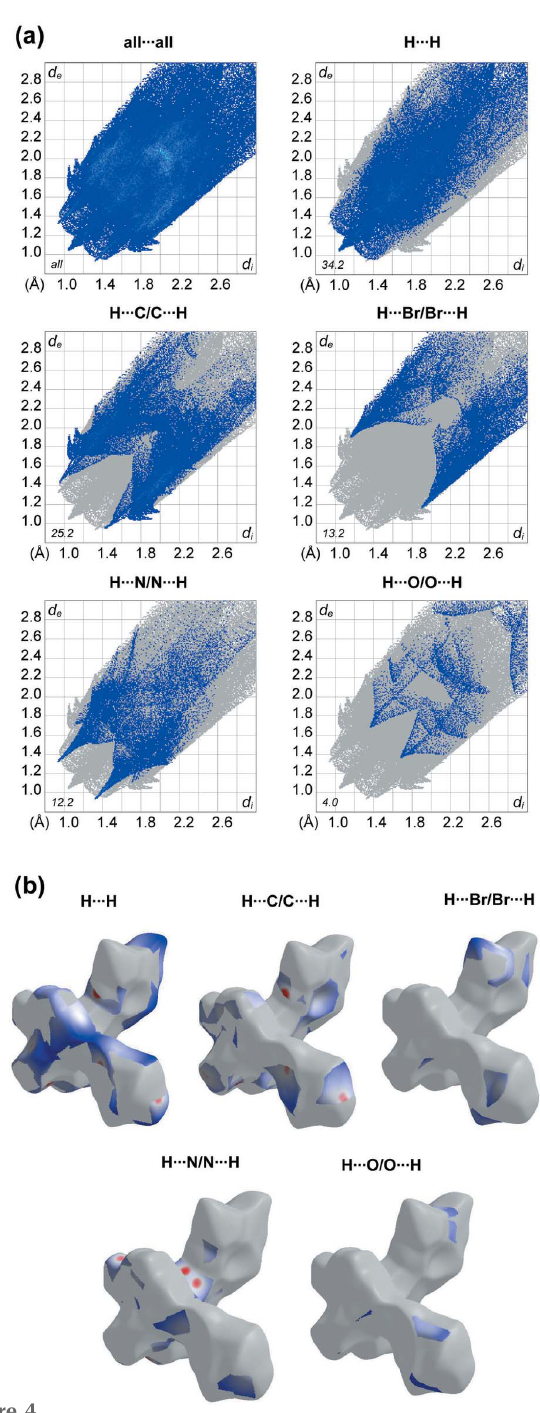
Figure 4 ( a ) The overall two-dimensional fingerprint plot and those decomposed into specified interactions. ( b ) Hirshfeld surface representations with the function d norm plotted onto the surface for the different interactions.